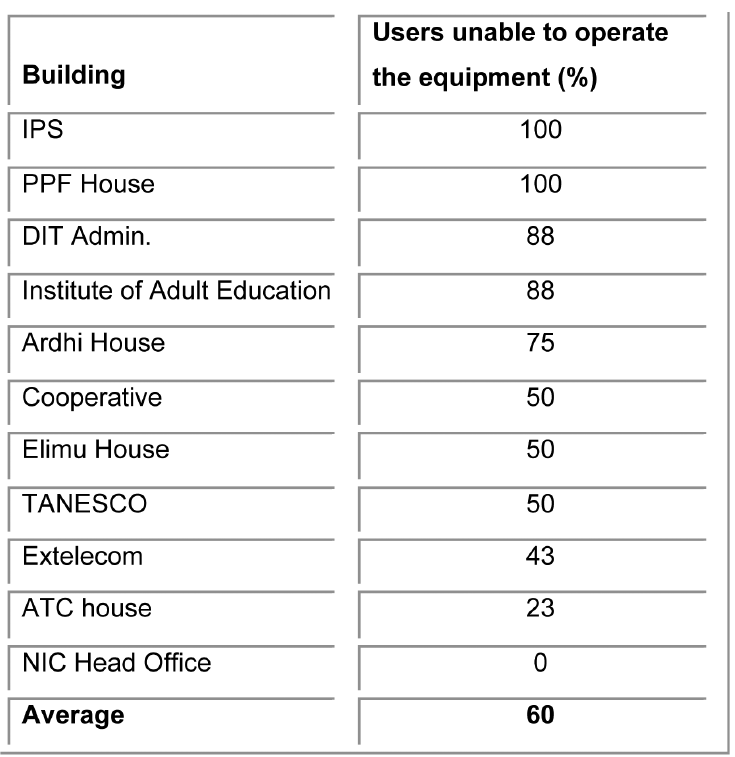
Table 5. Ability to use the